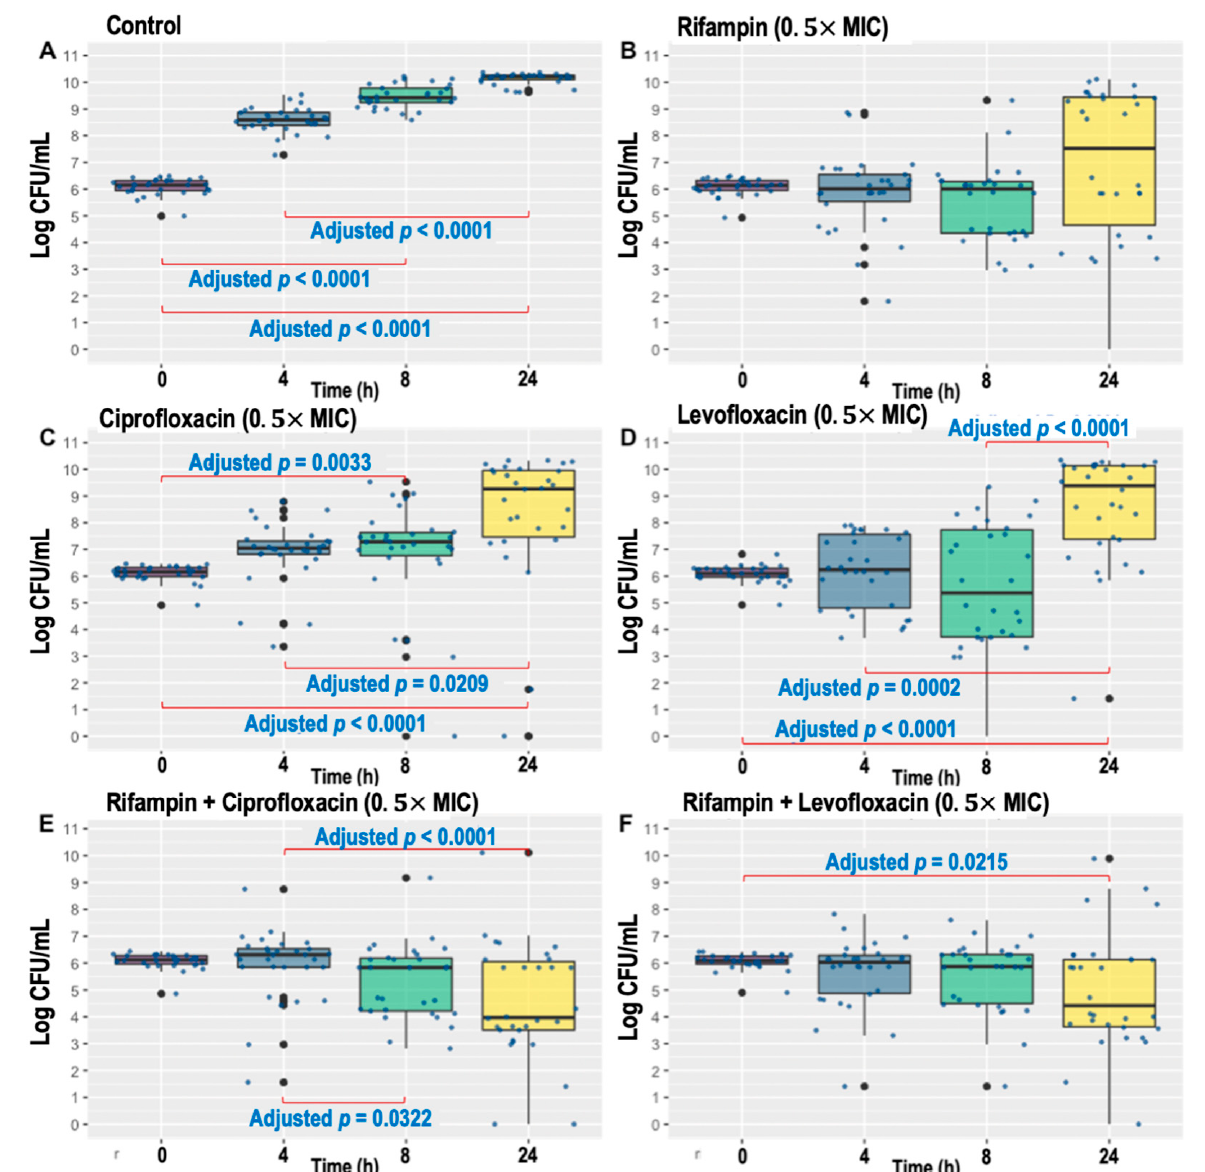
Figure 2. Changes in viable bacterial counts over 24 h after exposure to antibacterial agents at a concentration of 0.5 × MIC (minimum inhibitory concentration). ( A ) Changes in viable bacterial counts after exposure to control. ( B ) Changes in viable bacterial counts after exposure to rifampin. ( C ) Changes in viable bacterial counts after exposure to ciprofloxacin. ( D ) Changes in viable bacterial counts after exposure to levofloxacin. ( E ) Changes in viable bacterial counts after exposure to rifampin and ciprofloxacin. ( F ) Changes in viable bacterial counts after exposure to rifampin and levo fl oxacin.